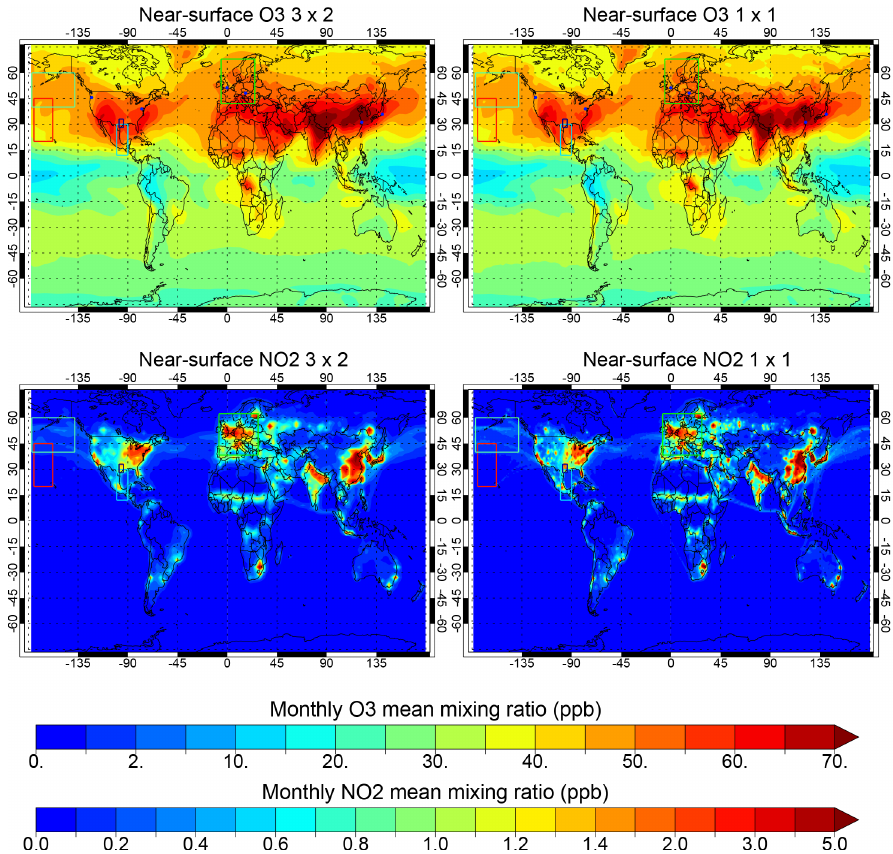
Figure 3. The near-surface distribution in tropospheric O 3 (top) and NO 2 (bottom) for May 2006 from the 3 ◦ × 2 ◦ (left) and 1 ◦ × 1 ◦ (right) TM5-MP simulations. The blue points represent the location of the MOZAIC airports used for comparisons. Also shown are the locations of the INTEXB and Texas-AQSII measurement campaigns, and the extent of the EMEP network in the European domain, used for the validation of the resulting O 3 and NO 2